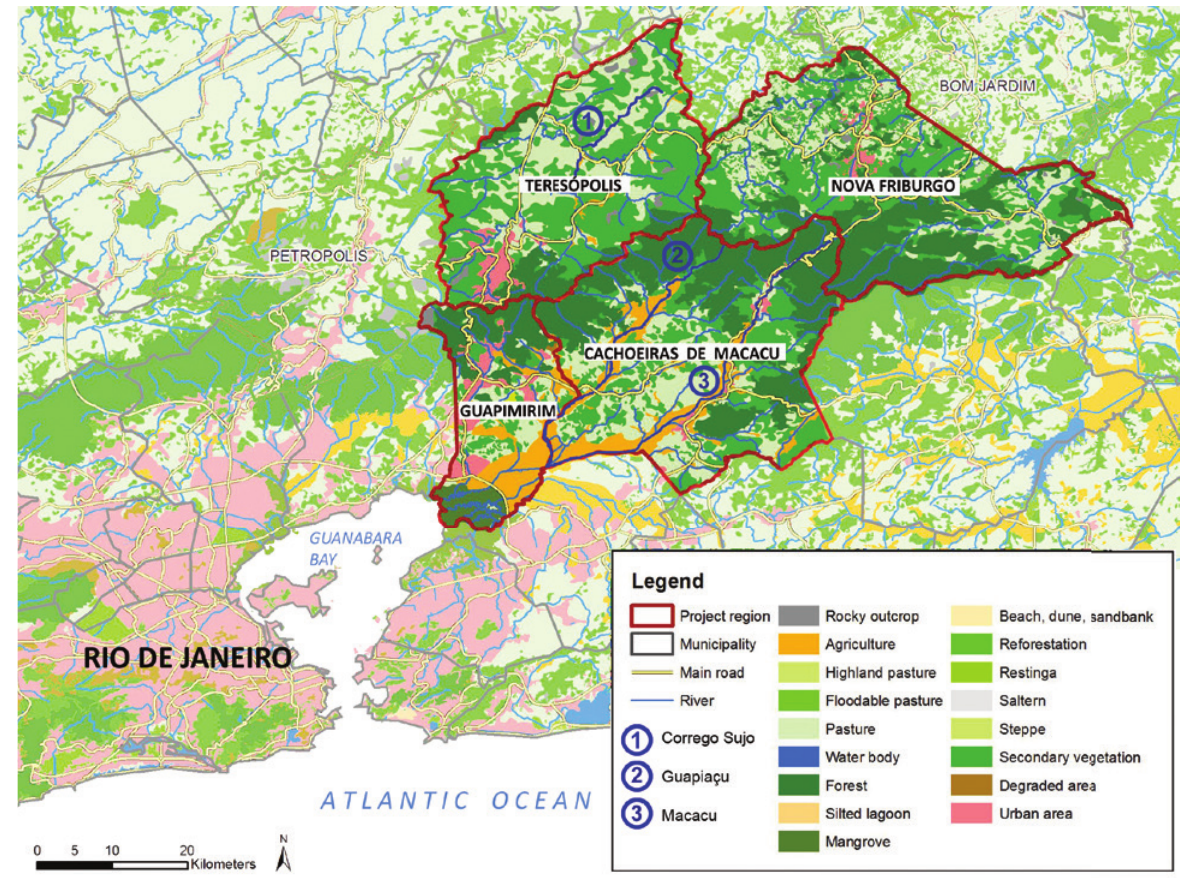
Figure 2 - Study area in the state of Rio de